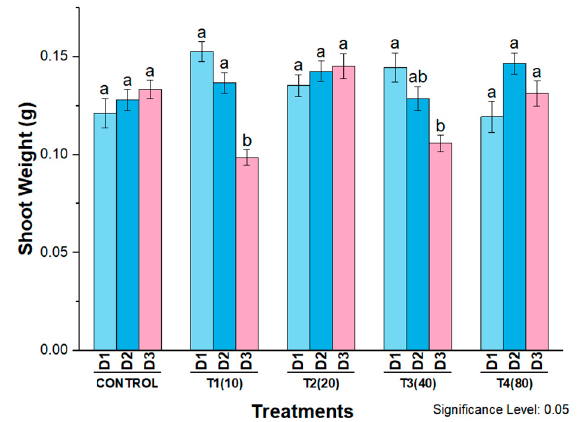
Figure 12. Shoot weight of wheat cultivar Bakhtawar-38 in response to 10, 20, 40, and 80 mg/L of AgNPs. All values are the average of 3 replicates, the error bars represent the standard errors of the means, and different letters indicate the significant difference at p = 0.05 by LSD test in each group.